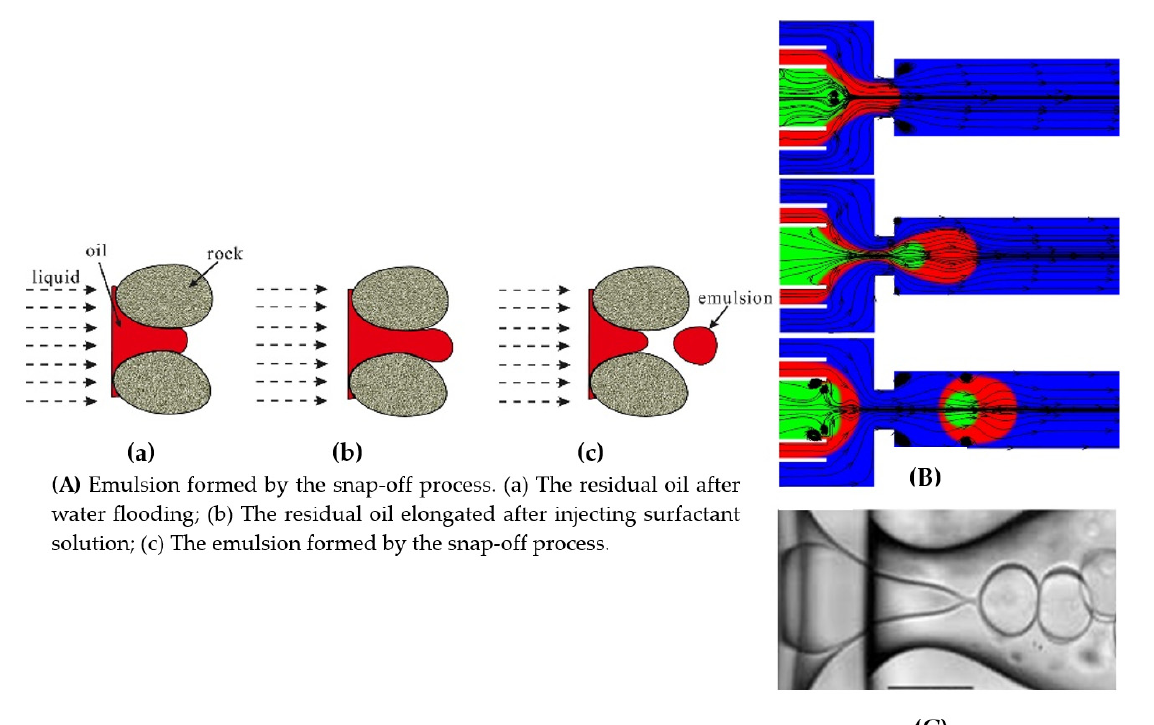
Figure 3. The formation of O/W emulsions by the snap ‐ off mechanism: ( A ) A schematic drawing of the snap ‐ off mechanism. ( B ) Simulation of the snap ‐ off mechanism by a ternary LBM. ( C ) An experiment image of the snap ‐ off mechanism.